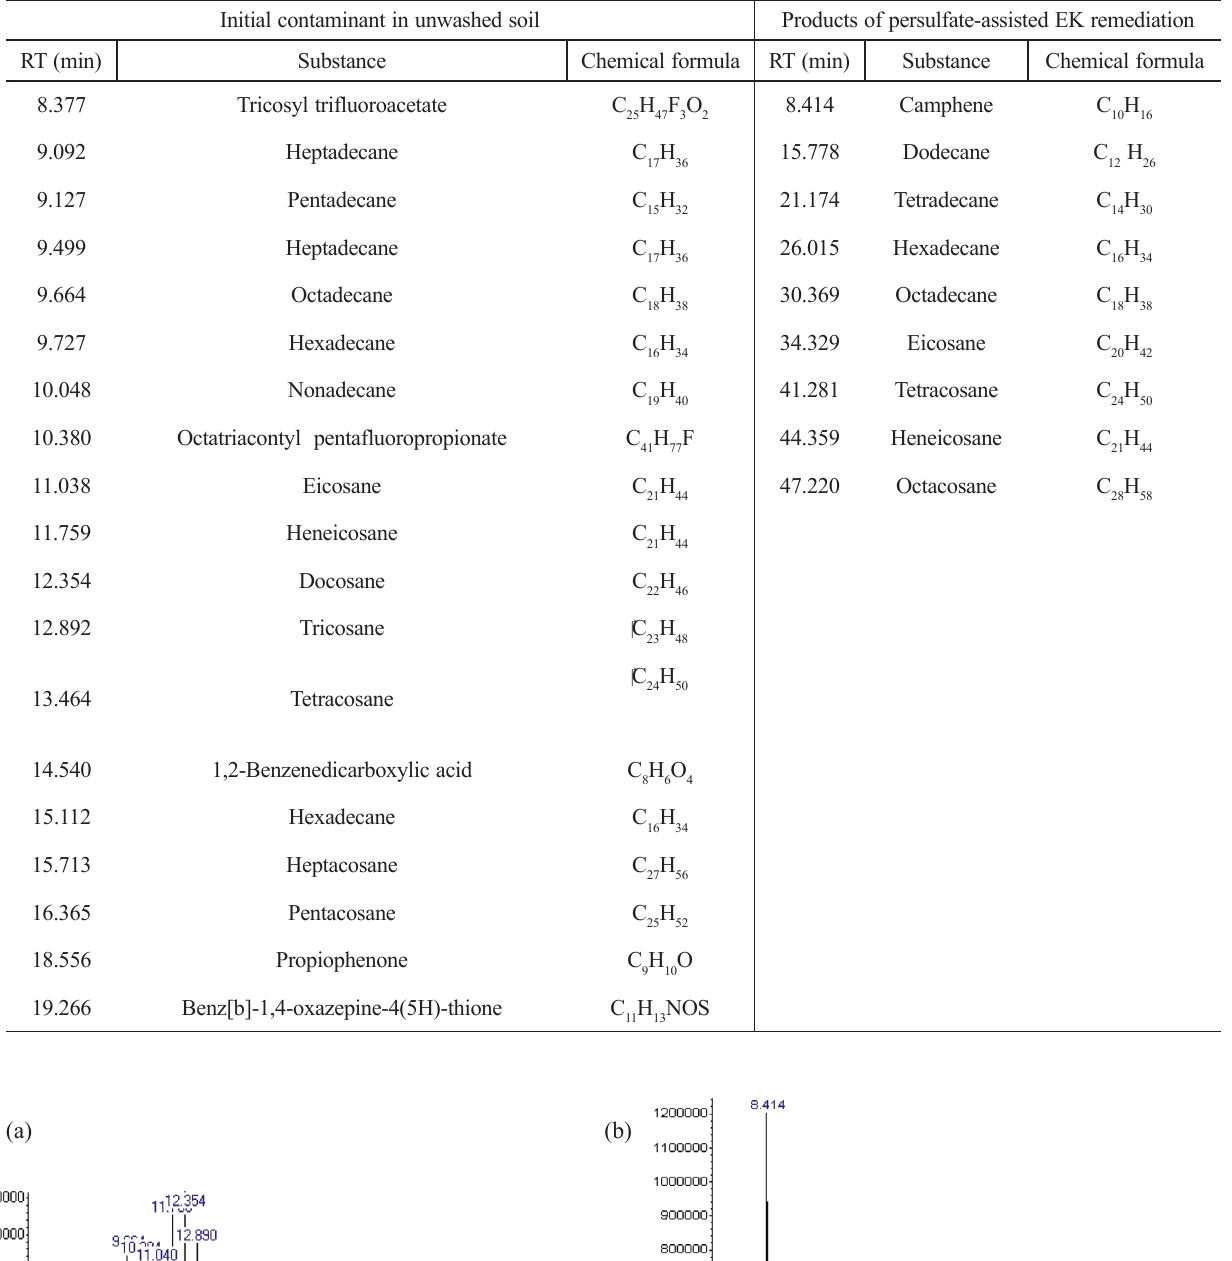
Table 2 – GC-MS analysis of the unwashed real hydrocarbon-contaminated soil before and after the persulfate-assisted EK (voltage: 1 V cm –1 , time: 24 h, pH: not adjusted, Tween 80: 20 mL kg –1 , persulfate: 100 mg kg –1 ) Initial contaminant in unwashed